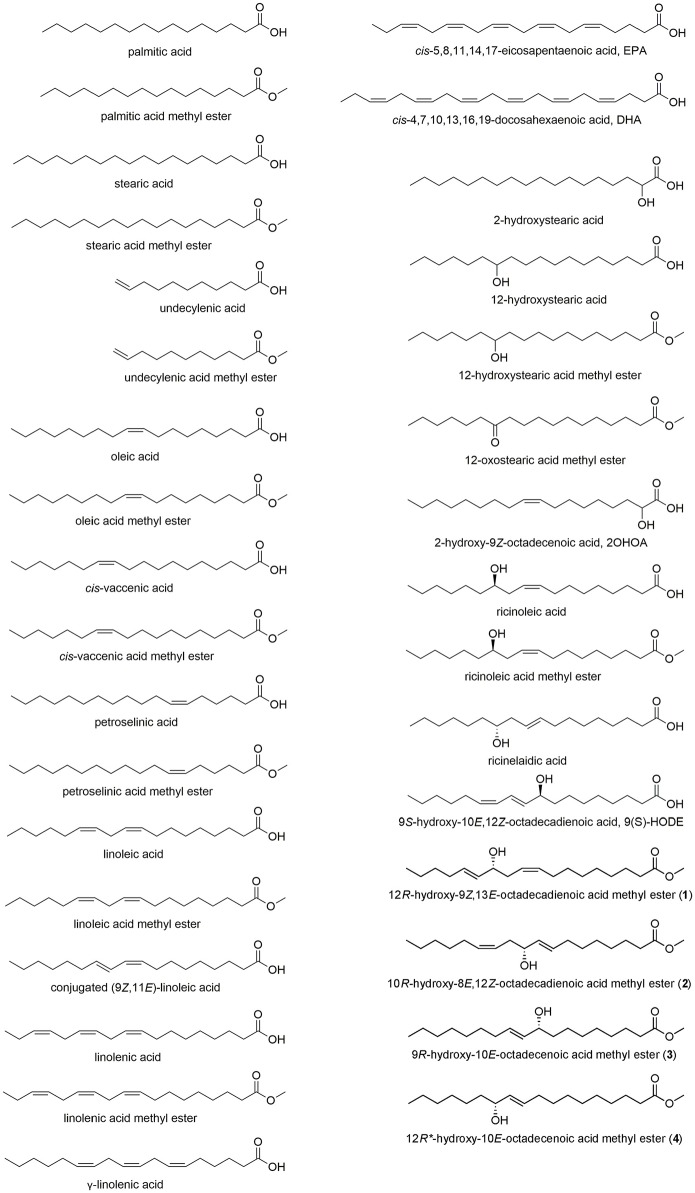
Structures of fatty acids, including the hydroxy fatty acids 1–4 isolated from Typhonium blumei.